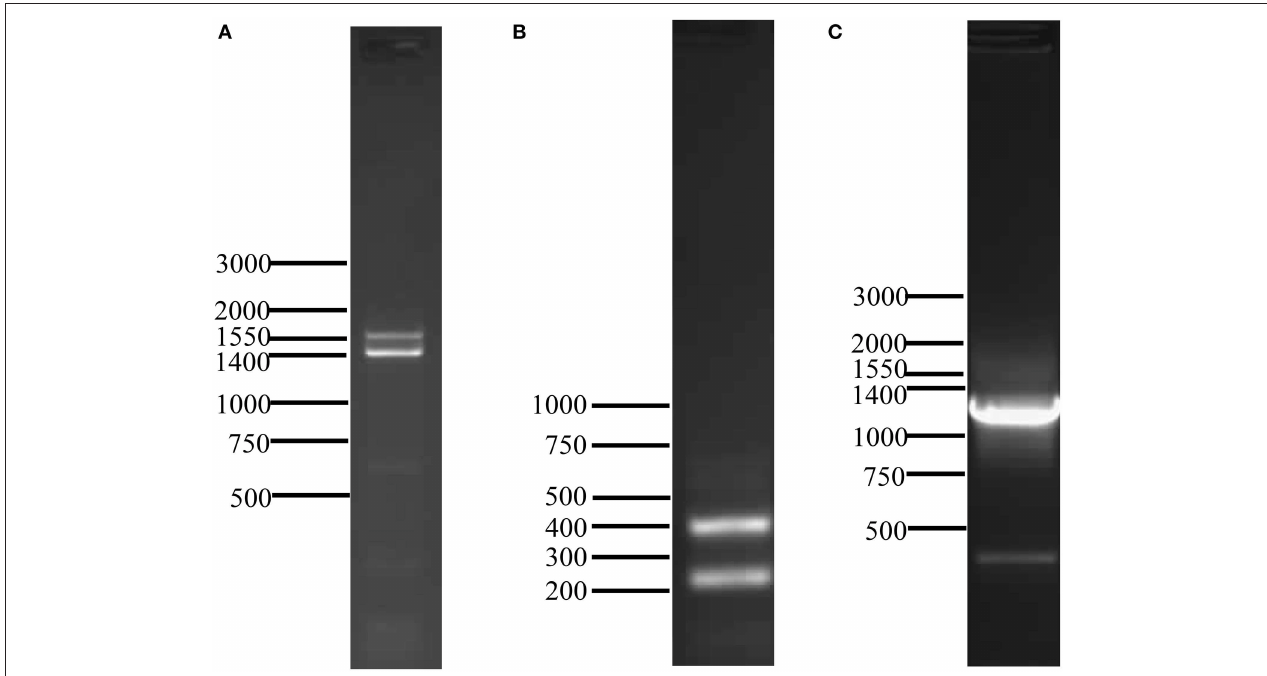
FIGURE 1 | PCR detection of AtraOR4 and AtraOR4A transcripts and 3 ′ end of AtraOR4 gene. (A) Full-length transcripts amplified by 3 ′ RACE. Amplification products were generated by 3 ′ RACE and visualized on 1% agarose gels by ethidium bromide staining and UV illumination. (B) RT-PCR detection of the 3 ′ end of AtraOR4 and AtraOR4A transcripts. Amplification using RT-PCR and transcript specific primers. PCR products were visualized on 1.5% agarose gels by ethidium bromide staining and UV illumination. (C) PCR detection of the 3 ′ end of AtraOR4 gene. Amplification was done using transcript specific primers and PCR product was visualized on 1% agarose gels by ethidium bromide staining and UV illumination.